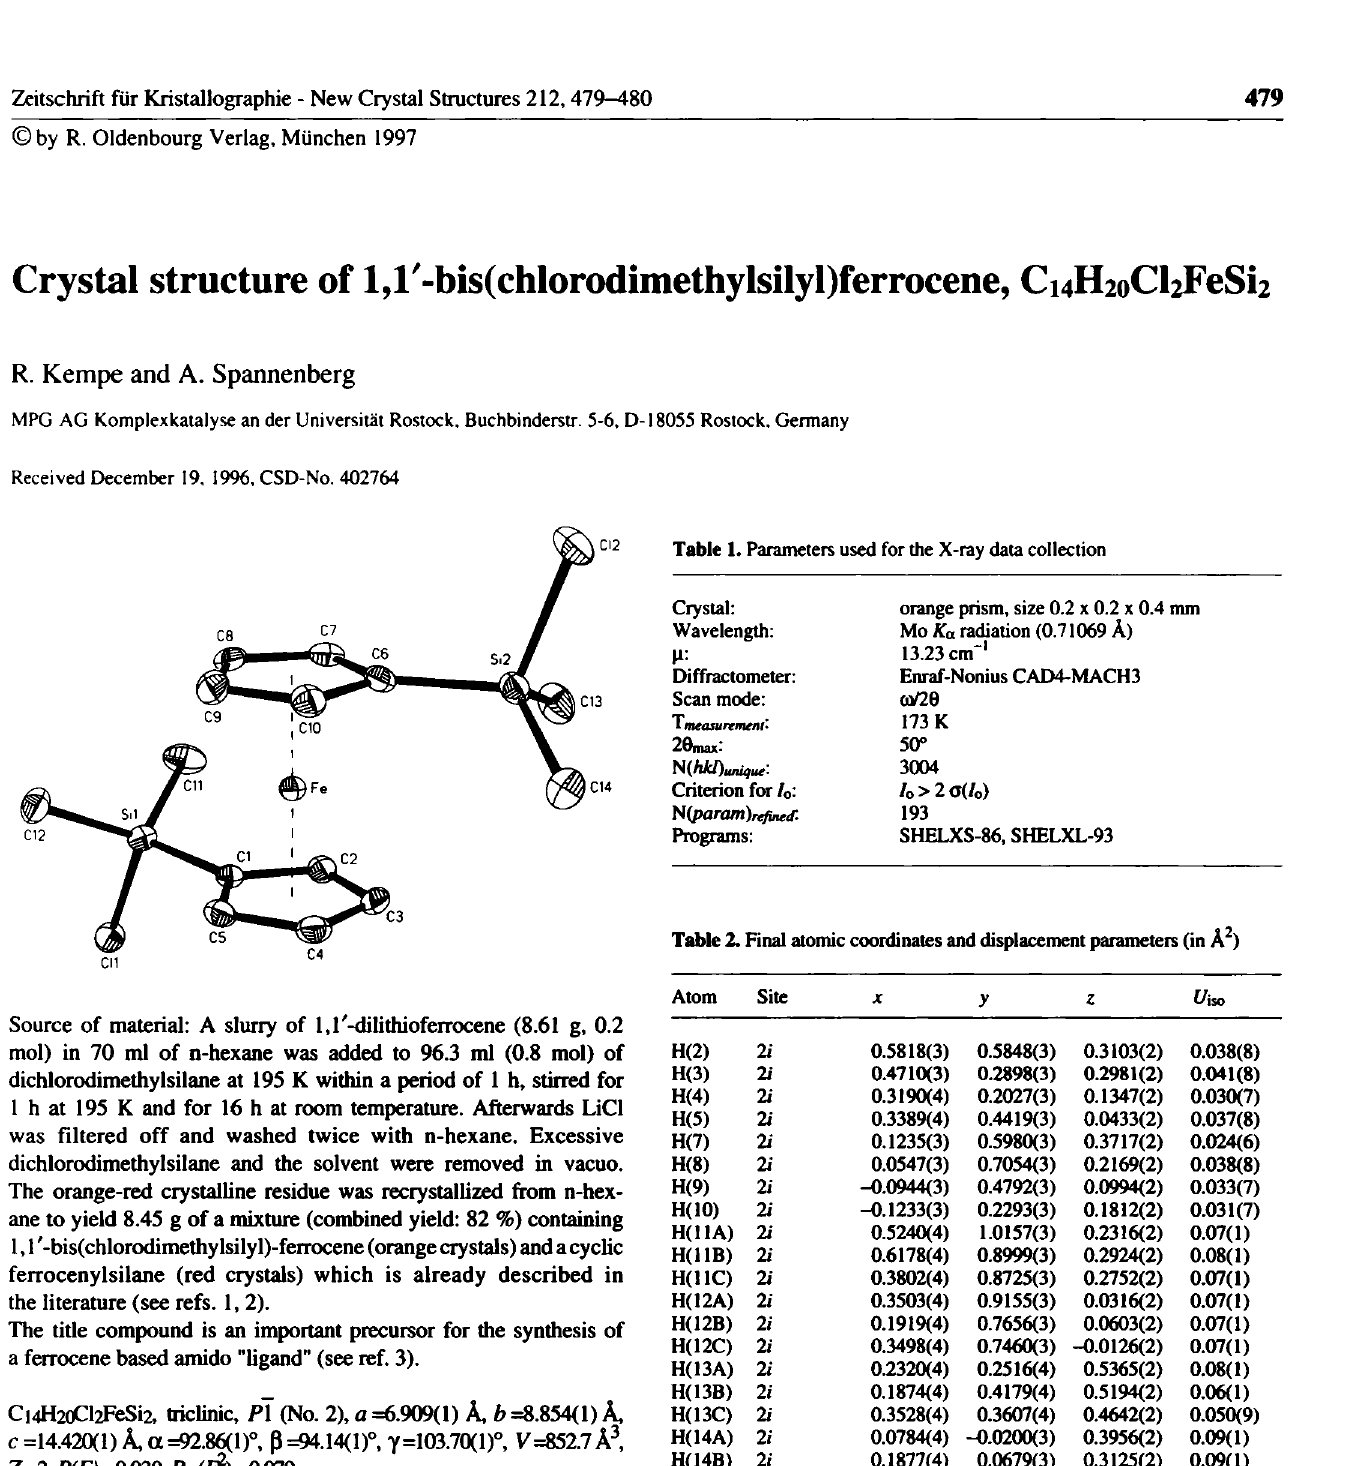
Table 3. Final atomic coordinates and displacement parameters (in Â 2